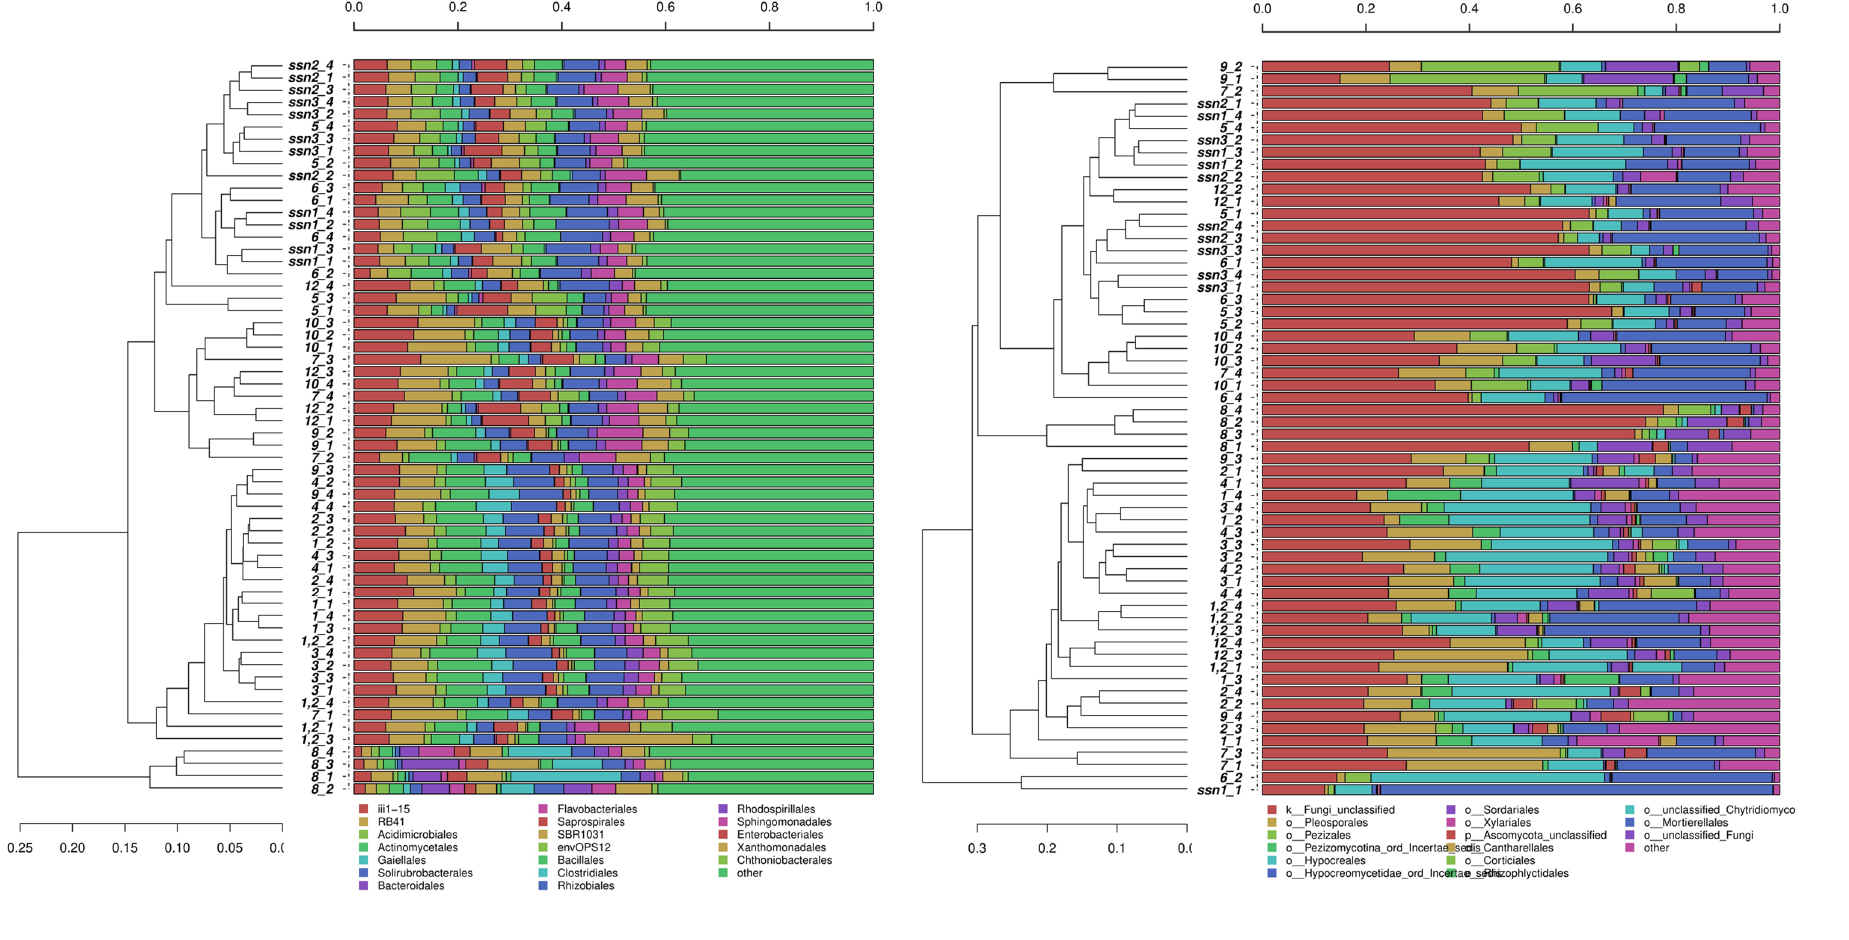
Figure 2. Taxonomic comparison of all samples (( a ) bacteria, ( b ) fungi) through hierarchical clustering of microbial communities at the order level across all samples used in this study. Clusters were identified with the average linkage algorithm for taxa that contributed at least 5% to a single sample. Taxa that contributed less than this threshold were added to the sequence group denoted “other.”